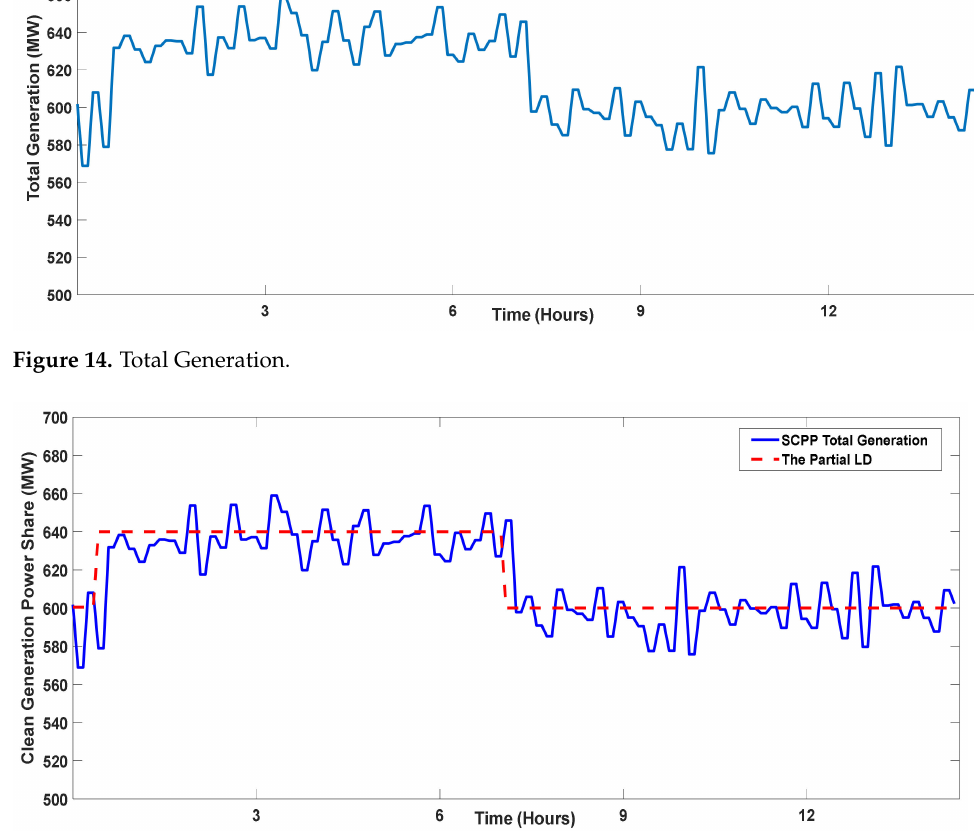
Figure 15. Total Generation and Load